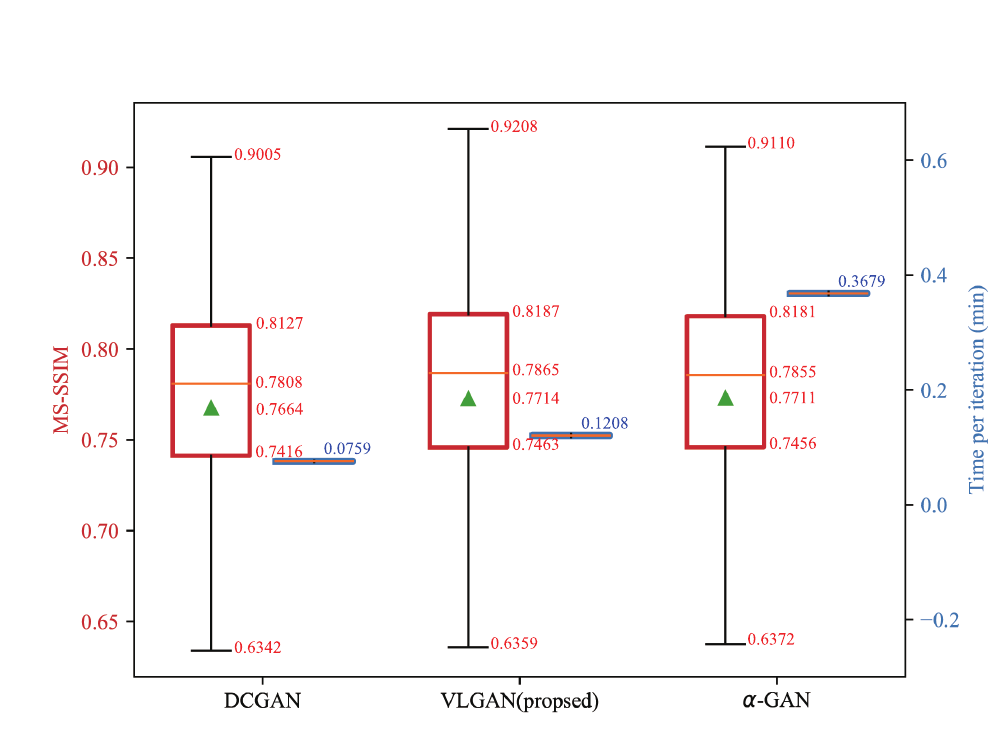
Figure 7. MS-SSIM and training time per iteration for the CelebA